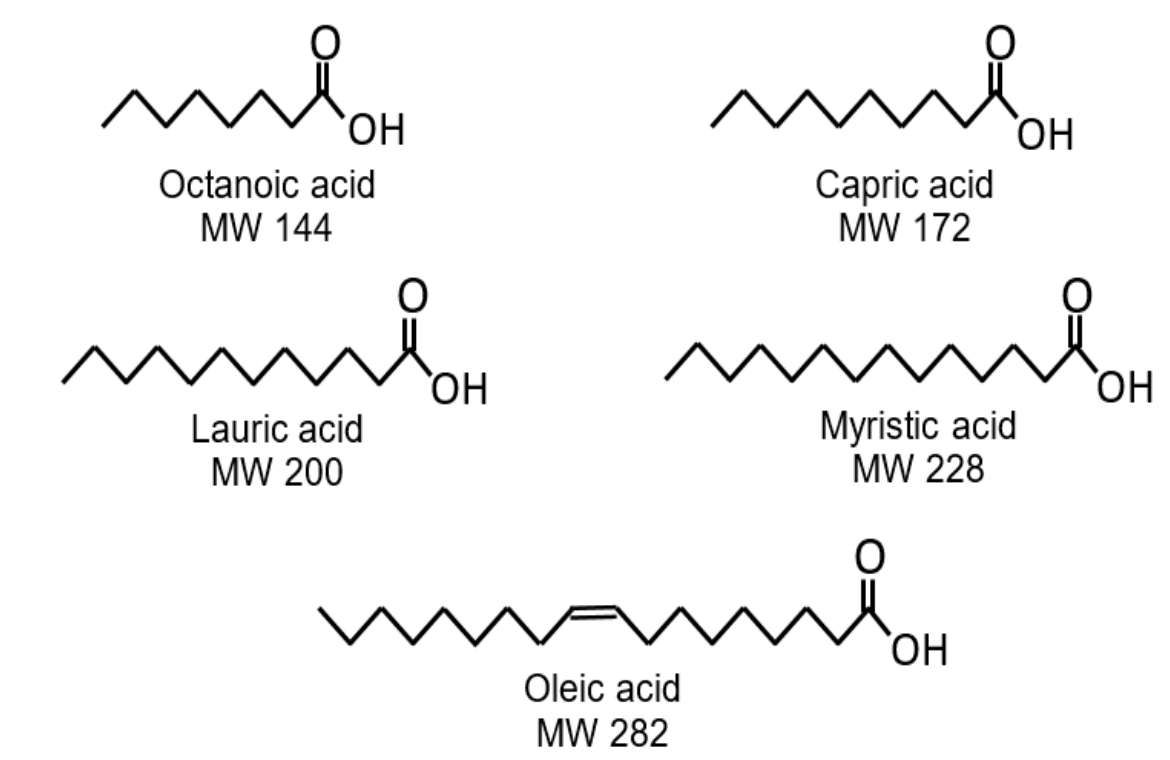
Figure 1. Molecular structure of the fatty acids tested in the current study. Table 2. Physical and solution properties of the studied fatty acids.